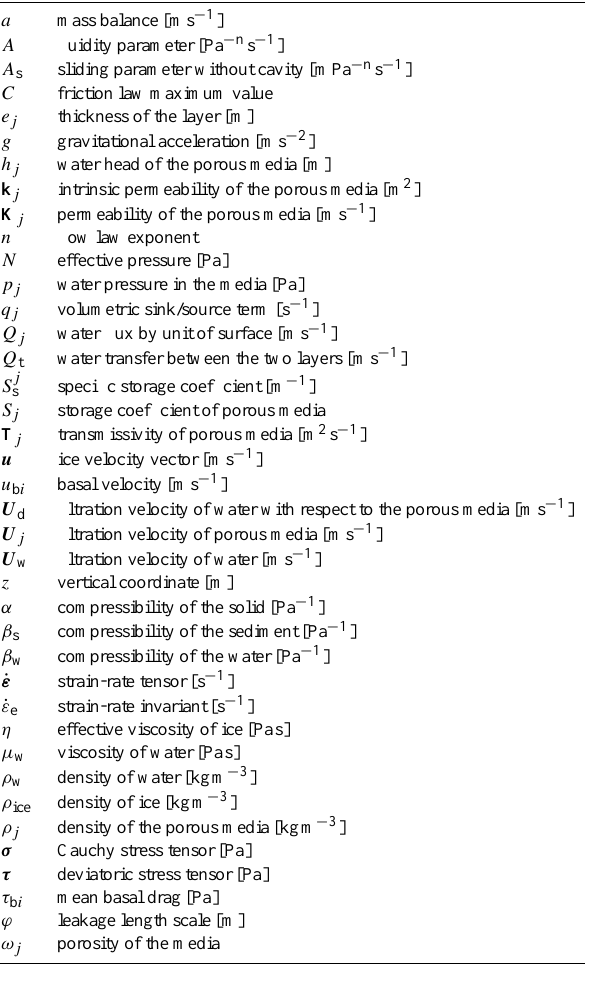
Table 1. Definition of the different variables, constants and param- eters in the model. As stated in Sect. 2.1, the subscript j is used to refer to the porous media in general, and j = i for the sediment layer IDS and j = e for the